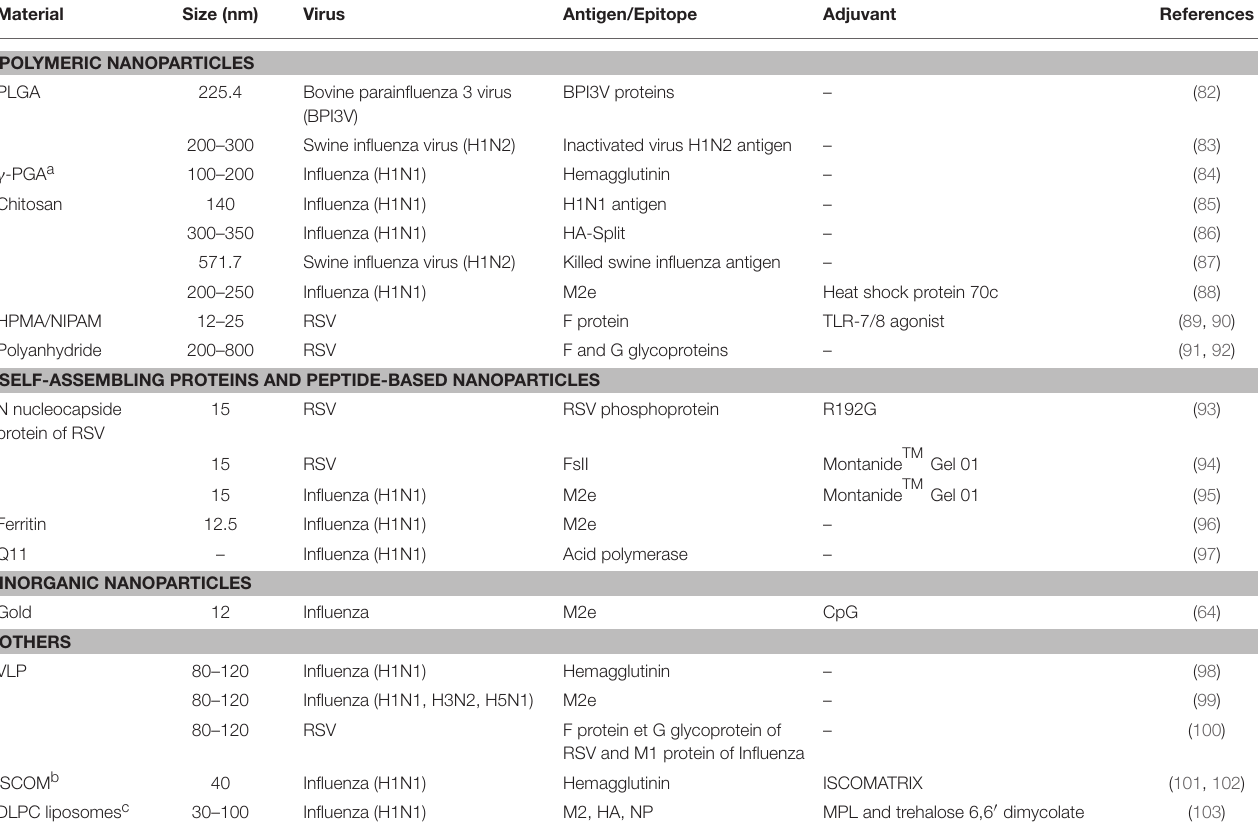
TABLE 1 | Nanoparticle-based vaccines against respiratory viruses delivered via the intranasal route.